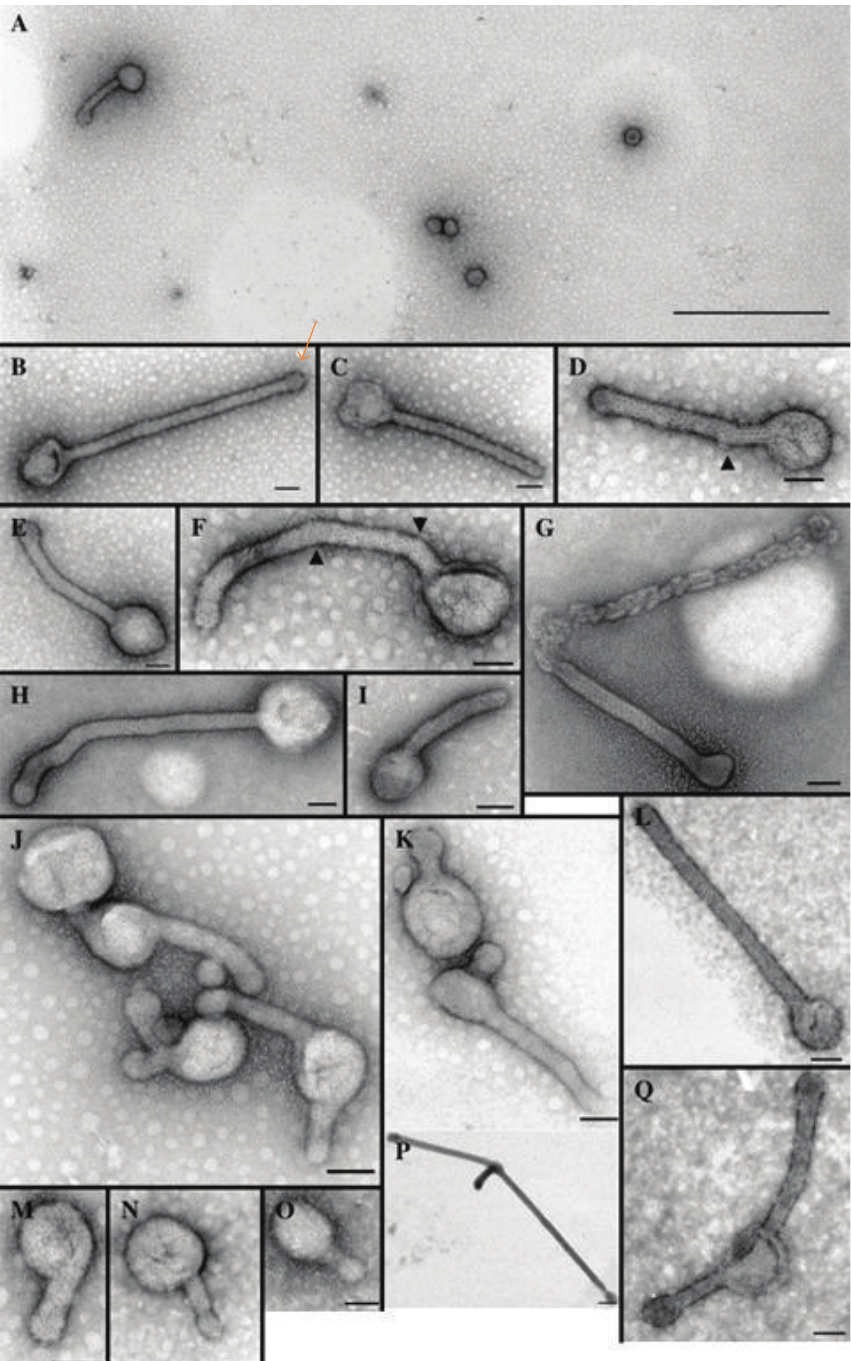
Figure 7: Electron micrographs of negatively stained furin sensitive double mutant E1-392/E2-341 containing virus recovered from the supernatant of transfected BHK-21 cells. (A) Low magnification of a typical sample of double mutant E1-392/E2-341. Bar, 1 𝜇 m. ((B)–(Q)). Selected particles demonstrating the variations seen in one preparation of E1-392/E2-341. Arrowheads show points of helical disruption and reinitiation. Bars, 100 nm. Kononchik et al. 2009